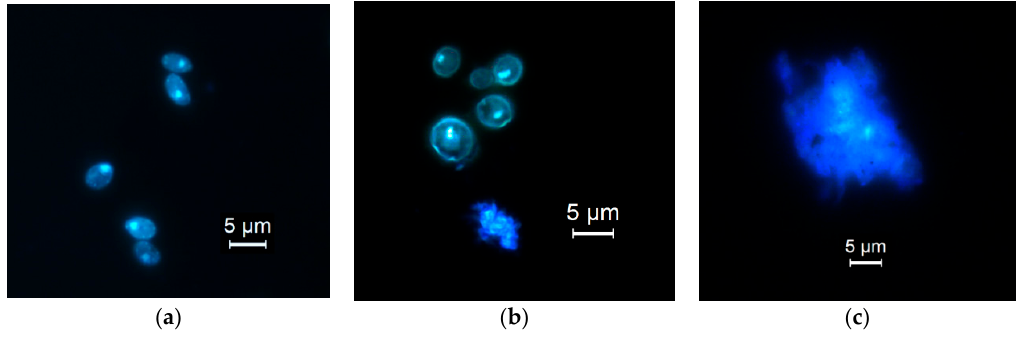
Figure 2. Illustration of morphological changes to yeast cells of S. cerevisiae at different treatment stages. ( a ) Untreated cells having a normal oval-shape; ( b ) Lemon myrtle extract (4% v / v ) cell treated for 30 min showing swollen round-shaped cells next to a membrane damaged cell and ( c ) treatment for 60 min exhibits clear cell membrane rupture.